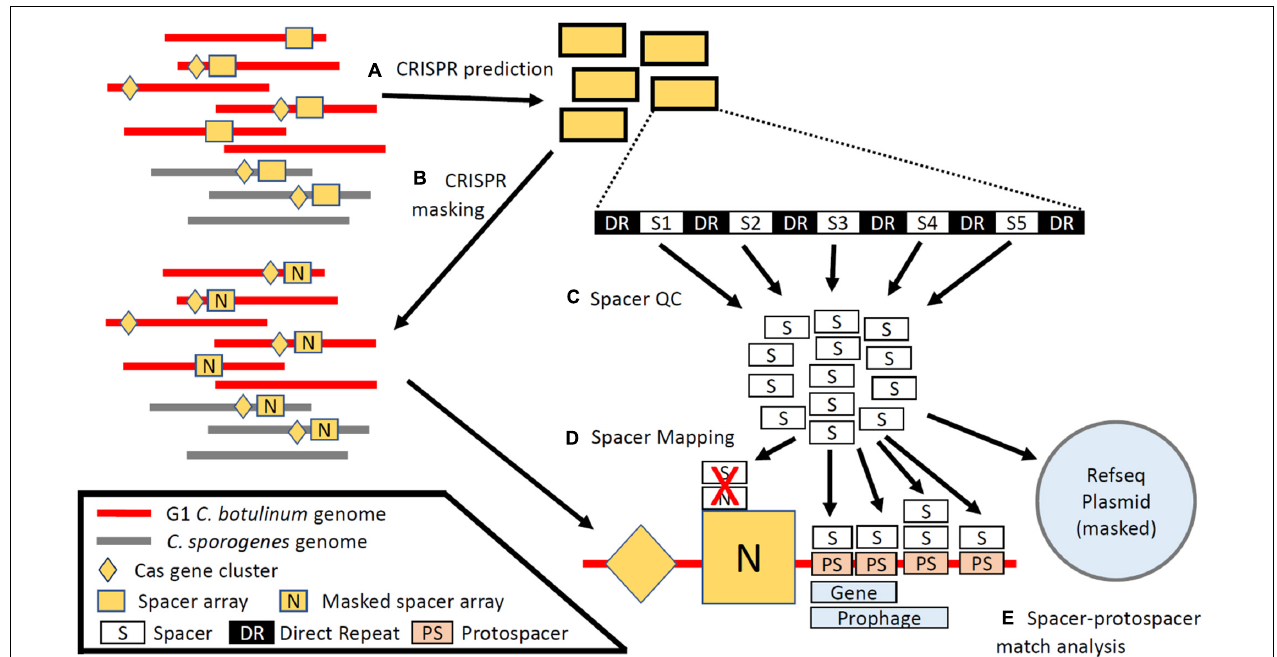
FIGURE 1 | Schematic of Cas and CRISPR array identification and protospacer prediction. (A) CRISPR arrays and Cas genes were predicted from 241 contig-level RefSeq assemblies of group I C. botulinum and C. sporogenes . (B) Predicted CRISPR arrays were used to mask the assemblies and the RefSeq plasmid datasets. (C) Spacers were parsed by length, array length, and distance to end of the contig. (D) Spacers were mapped back to the masked genomes and the RefSeq plasmid dataset to identify cognate protospacer sequences. (E) Spacer–protospacer matches were analyzed to determine protospacer localization and predicted